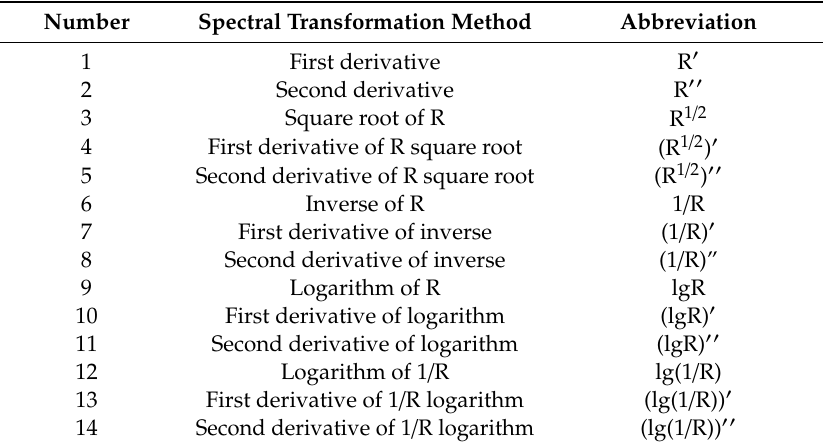
Table 1. Spectral transformation forms.